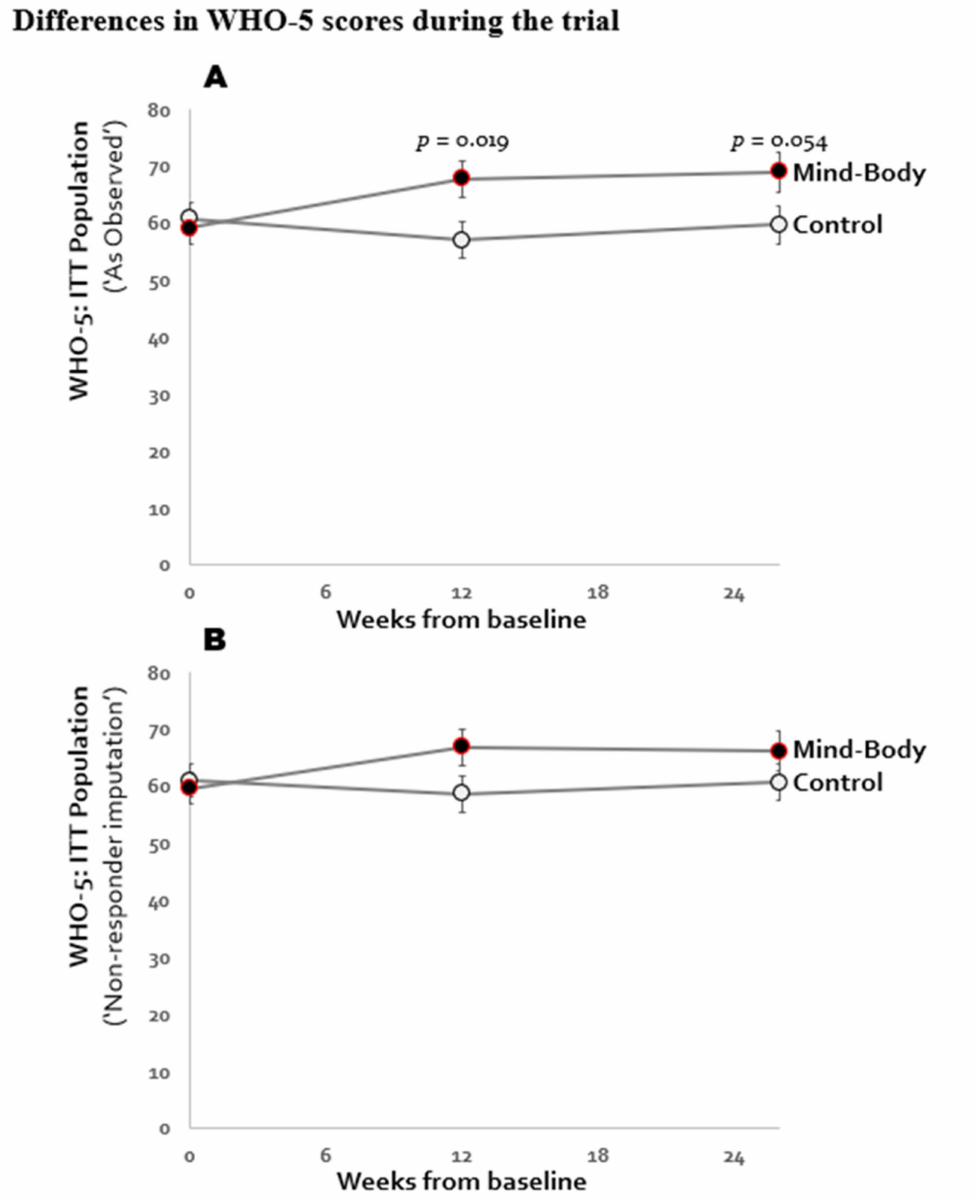
Figure 2. Least squared means WHO-5 from baseline throughout the 26-treatment period in the intention to treat (ITT) analysis, analyzing ( A ) as observed and ( B ) with non-responder